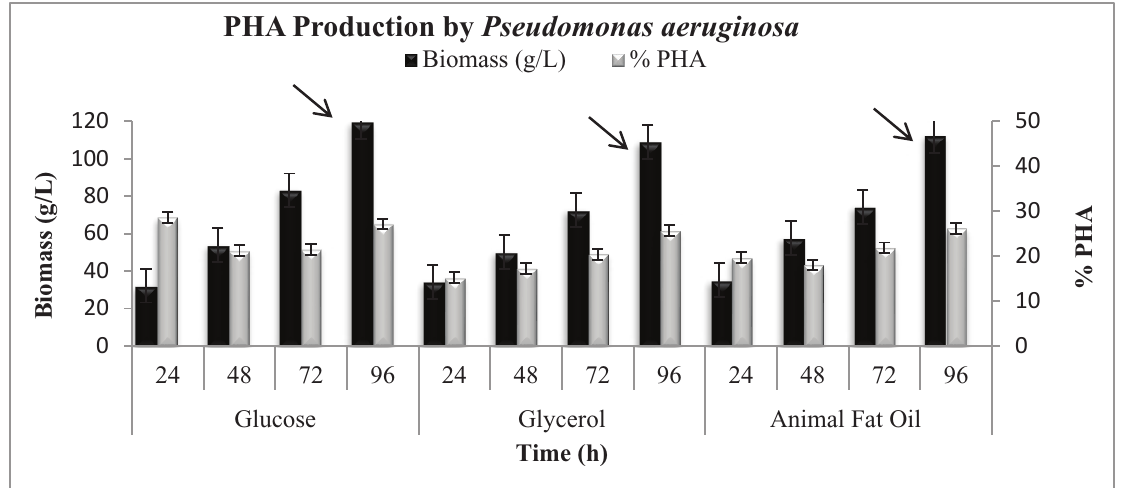
Figure 4: PHA production by strain PWC ( Pseudomonas aeruginosa ; MH142144). PHA production by strain PWC ( Pseudomonas aeruginosa ; MH142144) on all carbon sources was highest after 96 h. Biomasses and percentage PHA plotted against time are the mean of values recorded, during triplicate experiment. Standard error was